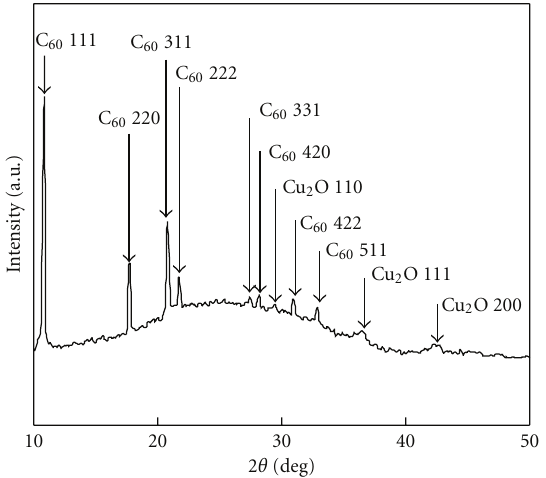
Figure 11: XRD pattern of Cu 2 O:C 60 thin film.